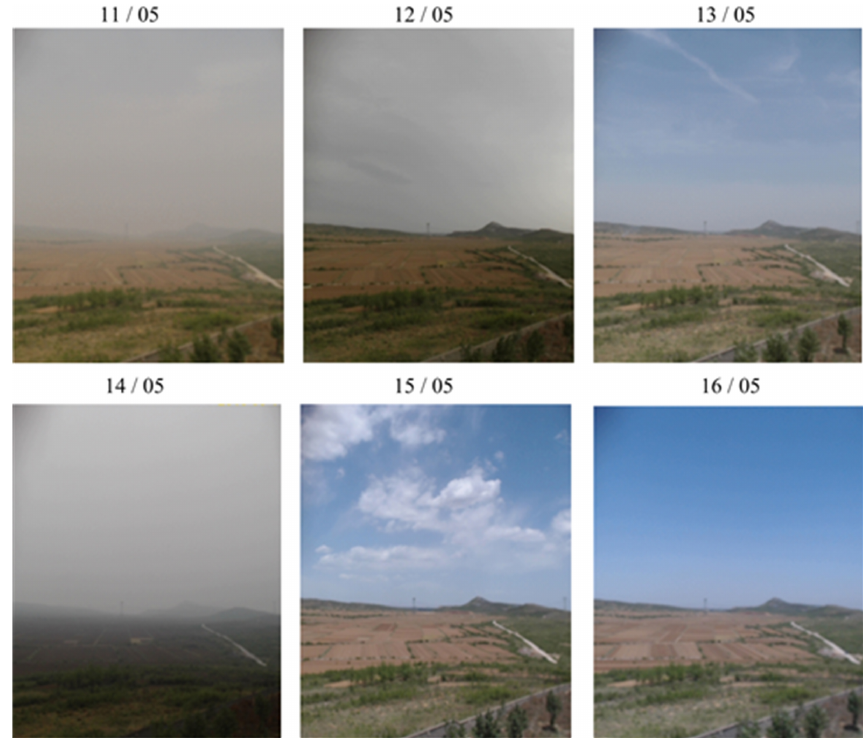
Figure 9. Photos taken by a camera along the line of sight of the MAX-DOAS instrument in the period from 11 to 16 May 2016 (left to